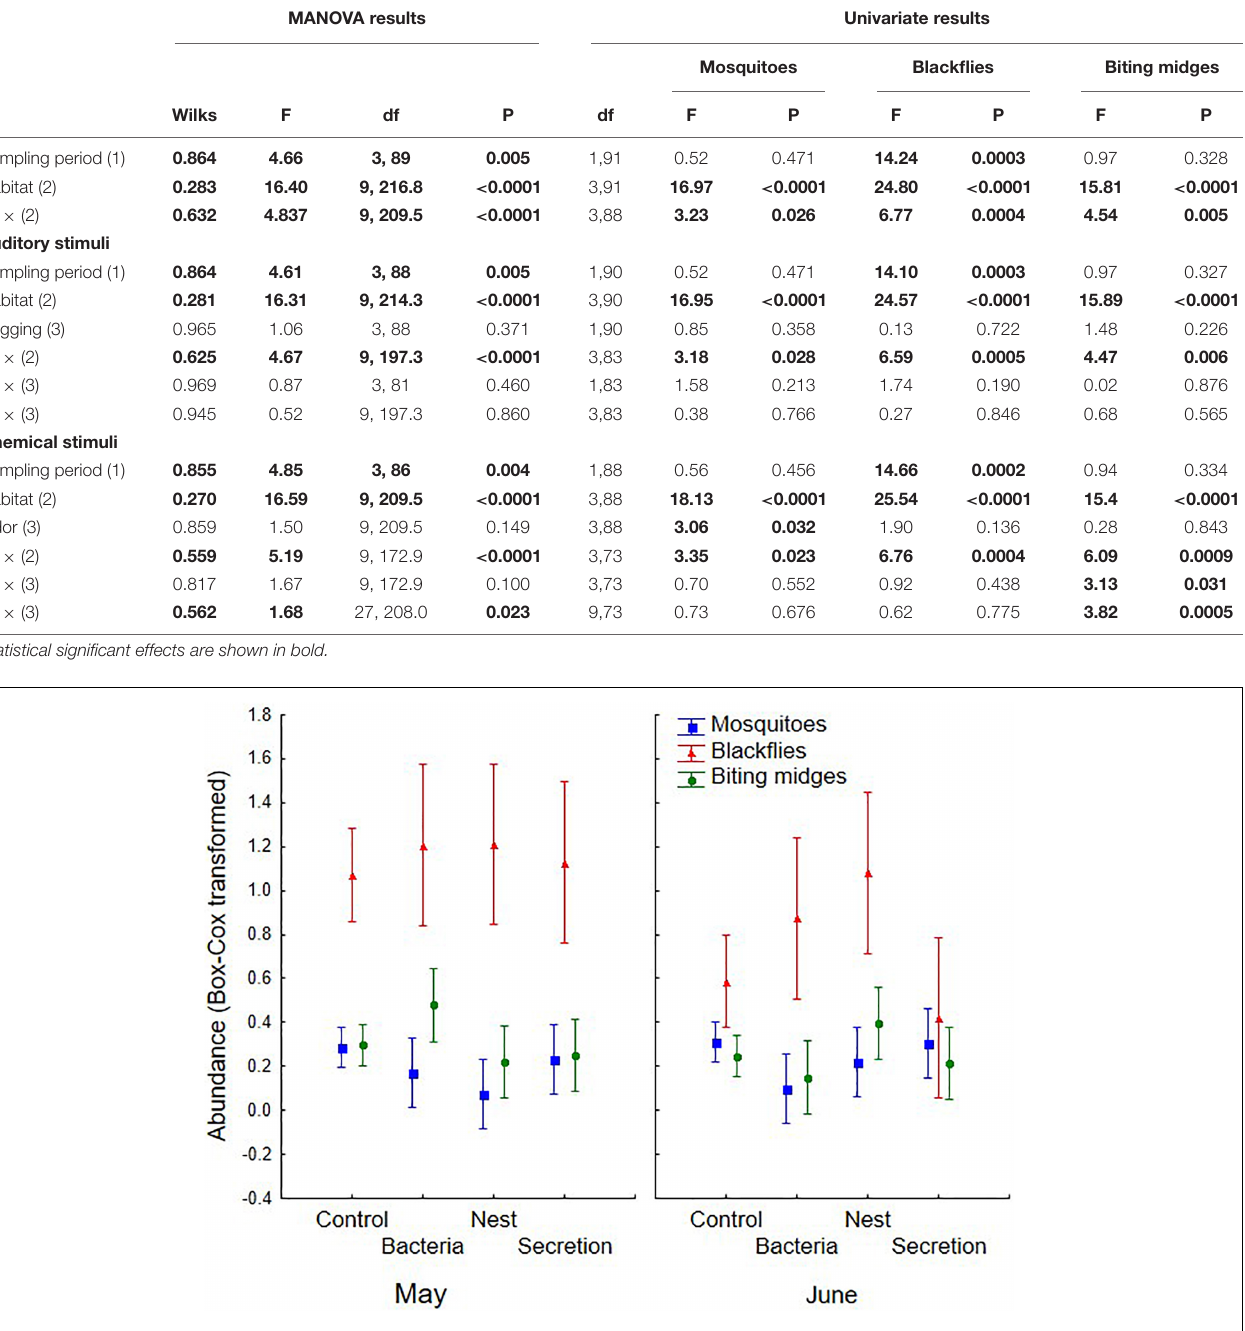
FIGURE 1 | Abundance of blood-feeding flies (mosquitoes, blackflies, and biting midges) collected in traps baited with different chemical stimuli derived from hoopoe nestlings or nests (uropygial secretion , nest material, or bacteria found in the secretion), or without stimulus ( control ), and in two sampling periods (May and June). Mean and 95% confidence intervals (CI) are